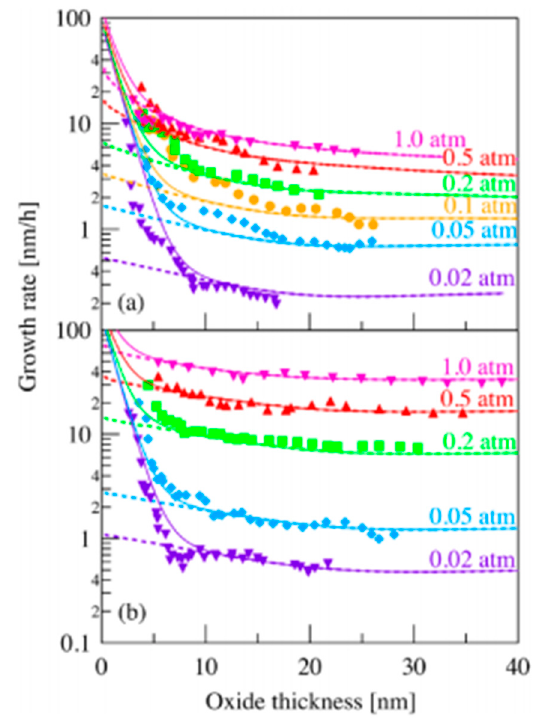
Figure 7. Comparison between experimental results and Si/C emission model for 1100 ◦ C oxidation: ( a ) Si-face and ( b ) C-face. Reprinted with permission from Reference [18]. Copyright 2019